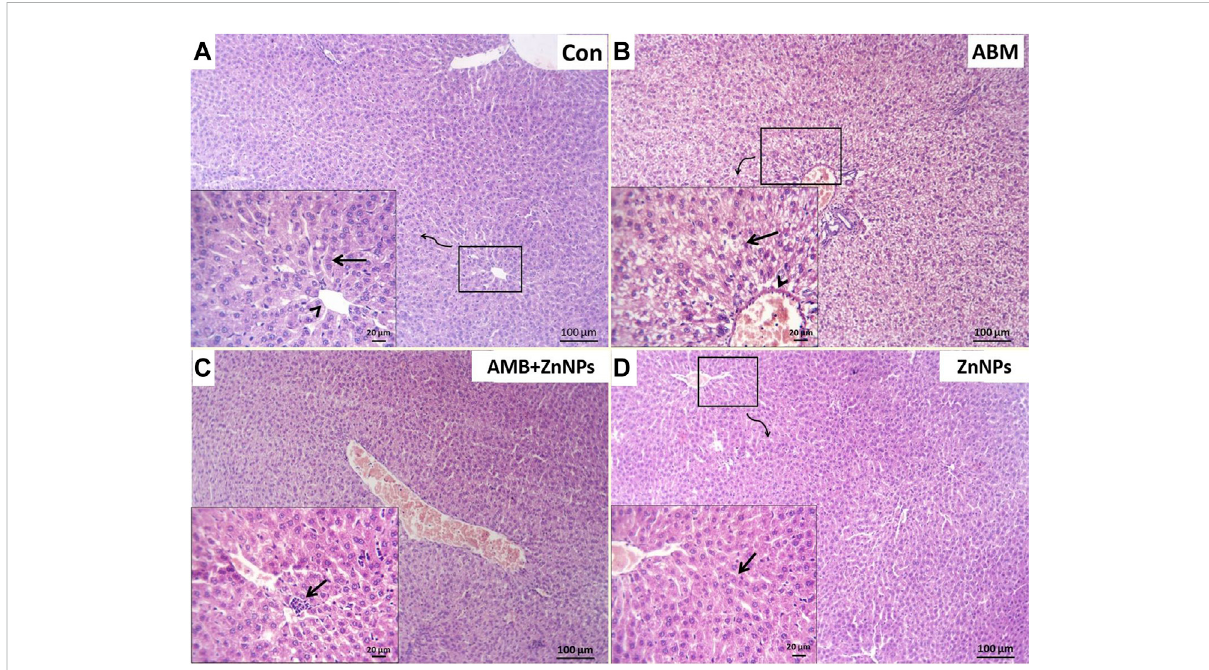
FIGURE 4 Photomicrograph of H&E stained sections from liver showing some parameters (degenerative changes, necrotic changes, congested blood vessels and round cells in fi ltration). (A) : Normal central vein (arrowhead) and hepatic cords (arrow) in control (G I). (B) : Severe degenerated and necrotic hepatocytes (arrow) with congested hepatic blood vessel (arrowhead) in rats group treated with abamectin (ABM; G II). (C) : Congested blood vessels and focally in fi ltration with minute round cells (arrow) in rats group treated with ABM + ZnNPs (G III). (D) : Apparently normal histological structures of hepatic tissue (arrow) in rats group treated with ZnNPs (G IV). Scale bar 100 μ m for large fi gures and 20 μ m for the small included fi